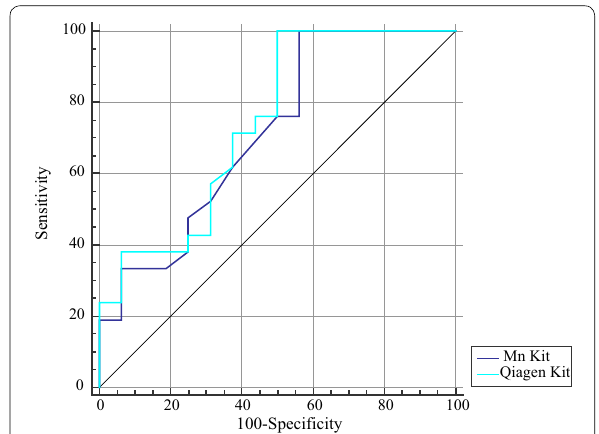
Fig. 2 ROC curve analysis for assessment of diagnostic power of cf DNA concentrations for differentiation of recurrence probability